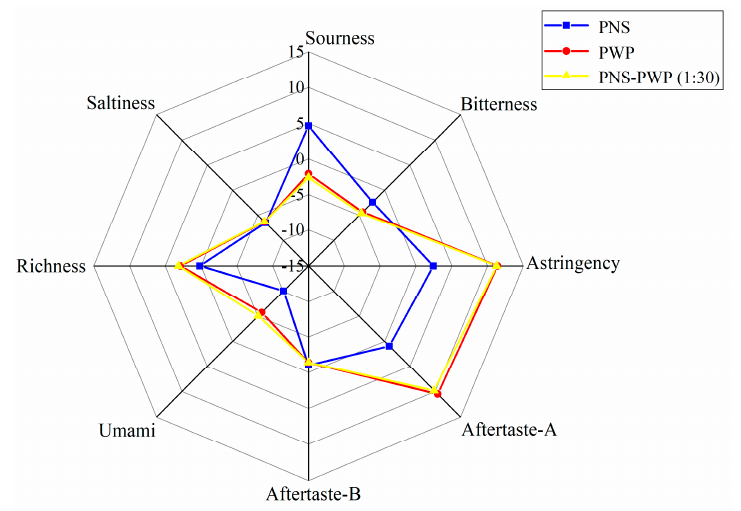
Figure 8. Radar chart of taste determination by the electronic tongue for PWP, PNS and PNS-PWP (1:30).